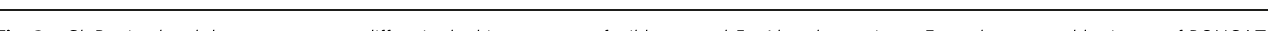
Fig. 2 mGluR-stimulated de novo proteome differs in the hippocampus of wild-type and Fmr1 knockout mice. a Example western blot image of BONCAT labeling of biotinylated de novo proteins made in wild-type (WT) and Fmr1 knockout (KO) hippocampal slices in response to the group I mGluR agonist DHPG (left panel, n = 3 WT with slices split evenly between Veh and DHPG, n = 3 KO with slices split evenly between treatments, p = 0.04; WT Veh vs WT DHPG, p = 0.06 WT Veh vs KO Veh, p = 0.32 KO Veh vs KO DHPG). In keeping with previous reports, no appreciable change in labeling was observed seen in KO slices stimulated with DHPG. (right panel). Sample western blot of time course of DHPG-induced de novo protein synthesis (right panel, n = 3 0 ′ and 60 ′ , p = 0.05, Student ’ s t -test, n = 2 for 15 ′ timepoint). b Schematic timeline and work fl ow of the BONLAC experiment. c Screens were performed for WT and KO separately. Both followed the same work fl ow and processing and were done on successive days from same batch of litters. Fold change vs intensity distribution plot of all detected proteins in WT + / − DHPG (top) or KO + / − (bottom) hippocampal proteome in blue and gray respectively ( n = 9 WT Veh, n = 9 WT DHPG, n = 8 KO Veh, n = 8 KO DHPG divided in 3 biological replicate groups per treatment condition per genotype). Overlay with red scatter plot depicts candidate proteins that were consistently altered using cut-offs derived from C-score rank score algorithm. n = 3 MS runs for 3 mice per genotype, per condition, per run. d Pie-chart breakup of total number of proteins measured across all runs and consistently upregulated and downregulated candidates from WT and KO screens (top and middle panel). Venn diagram depicting overlap in candidate identities between WT + DHPG and KO + DHPG screens (bottom panel). e Top Gene Ontology candidates in KO DHPG screen in Cell Membrane and Biosynthesis categories from DAVID